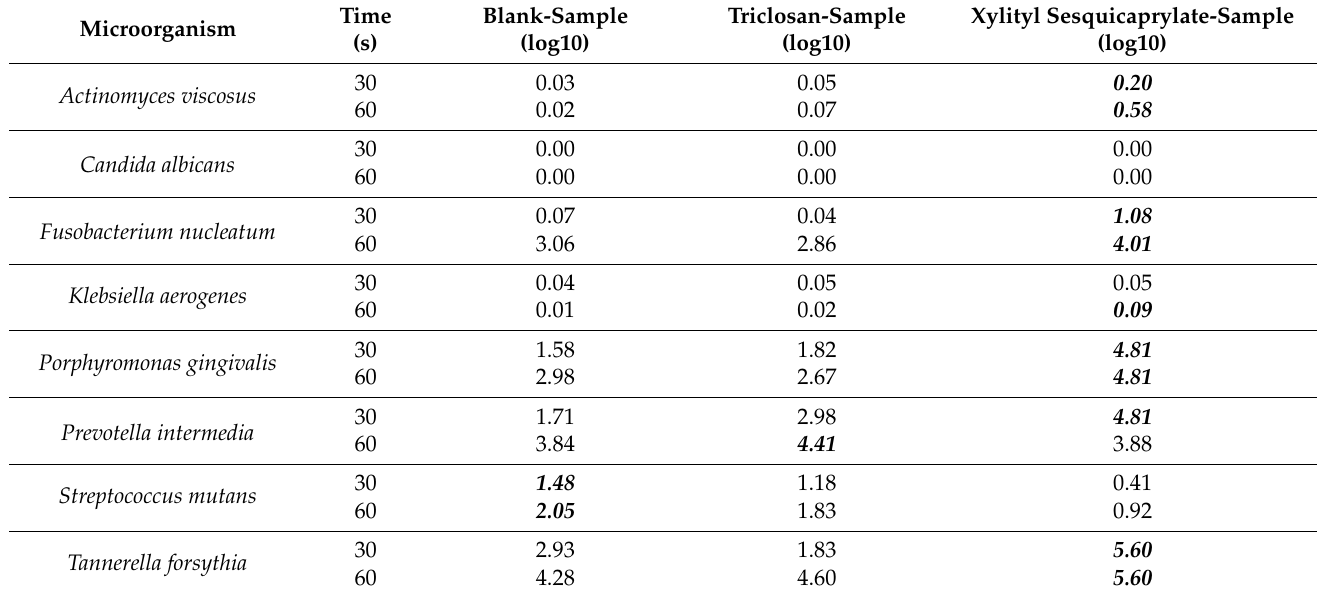
Table 1. Log 10 reductions of the microorganisms from the time-kill kinetic test for the mouth- wash